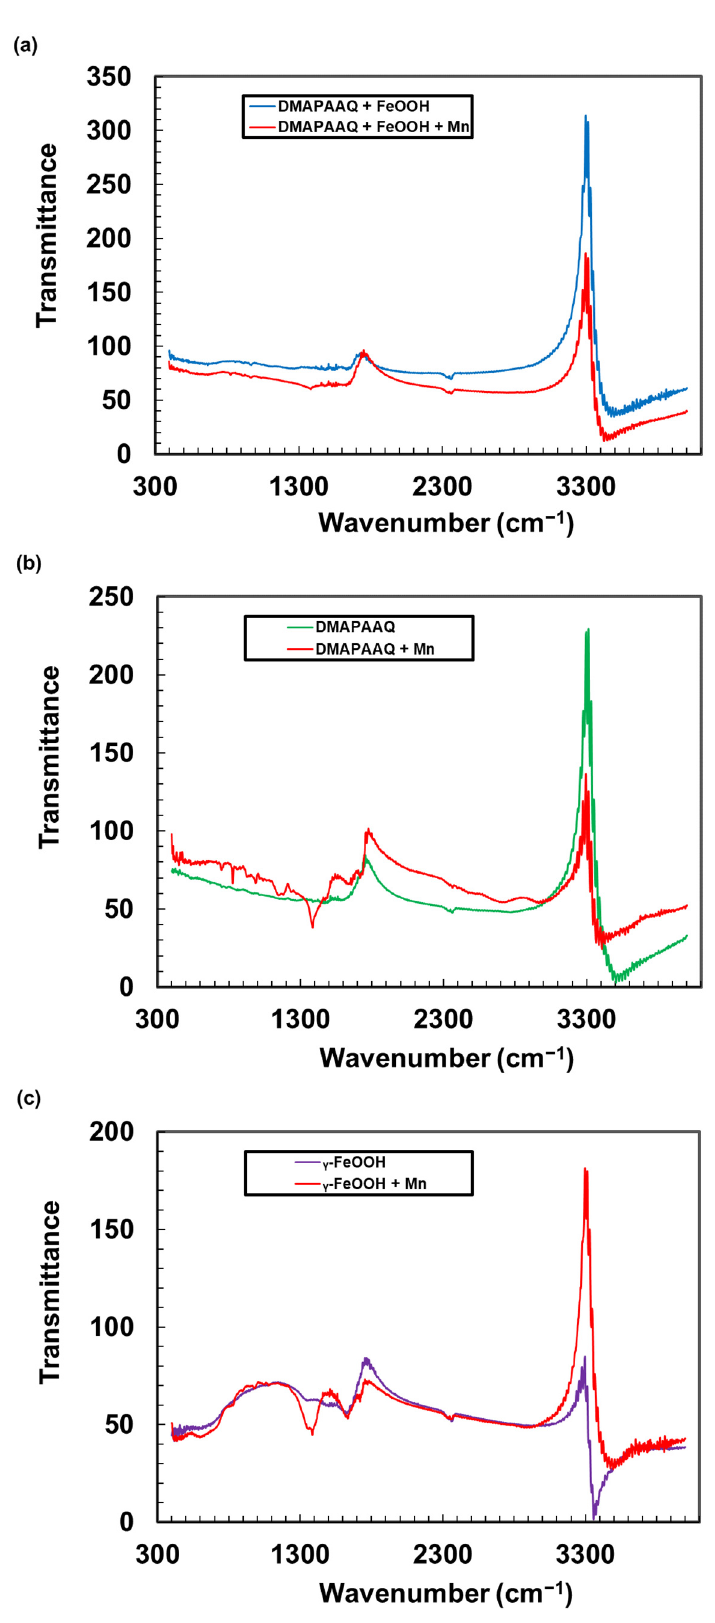
Figure 5. Comparative FTIR analysis of ( a ) DMAPAAQ + FeOOH and Mn-loaded DMAPAAQ + FeOOH, ( b ) DMAPAAQ and Mn-loaded DMAPAAQ, and ( c ) γ -FeOOH and Mn-loaded γ -FeOOH.